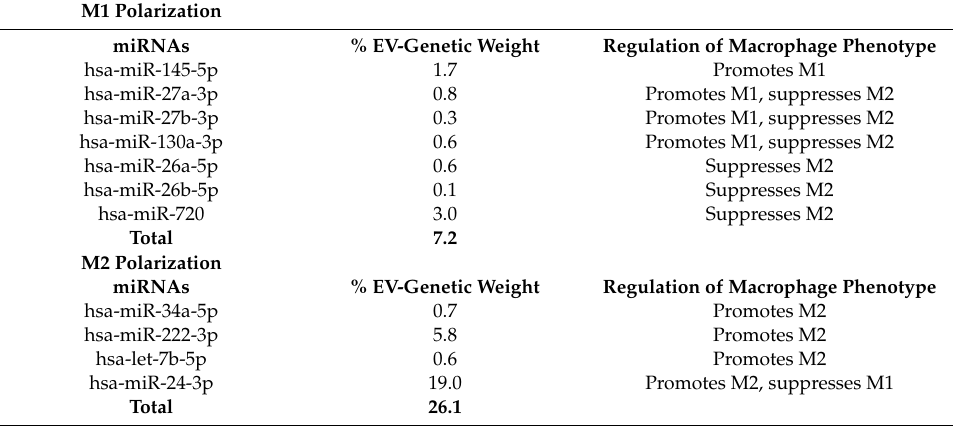
Table 4. First-quartile EV-miRNAs involved in macrophage